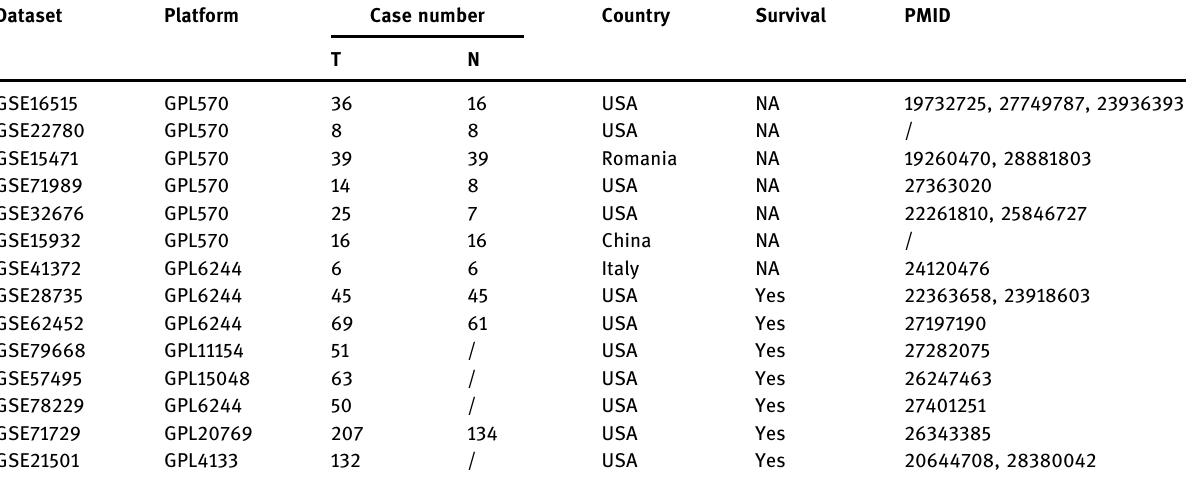
Table 1: Characteristics of the 14 datasets included in the analysis